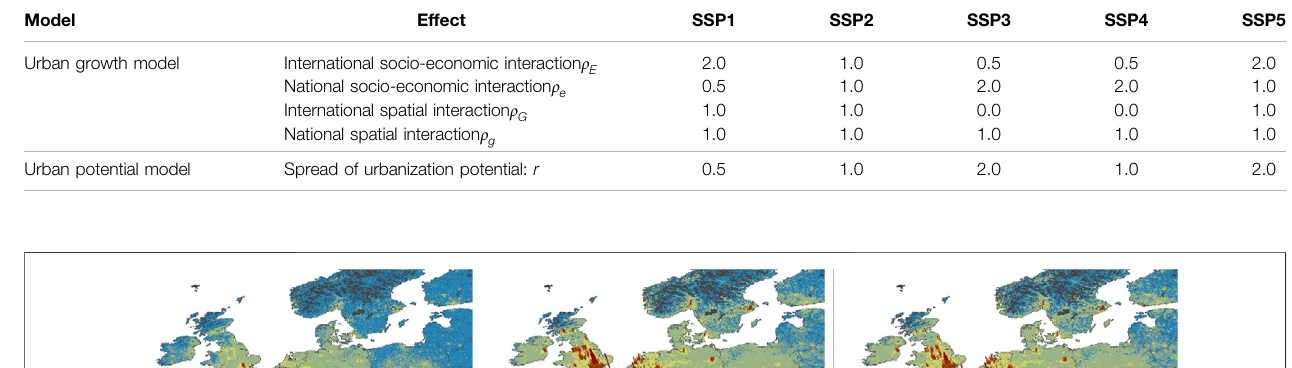
TABLE 2 | Assumptions for the parameters in 2,100 in the urban growth model (SSP2: 1.0). Model